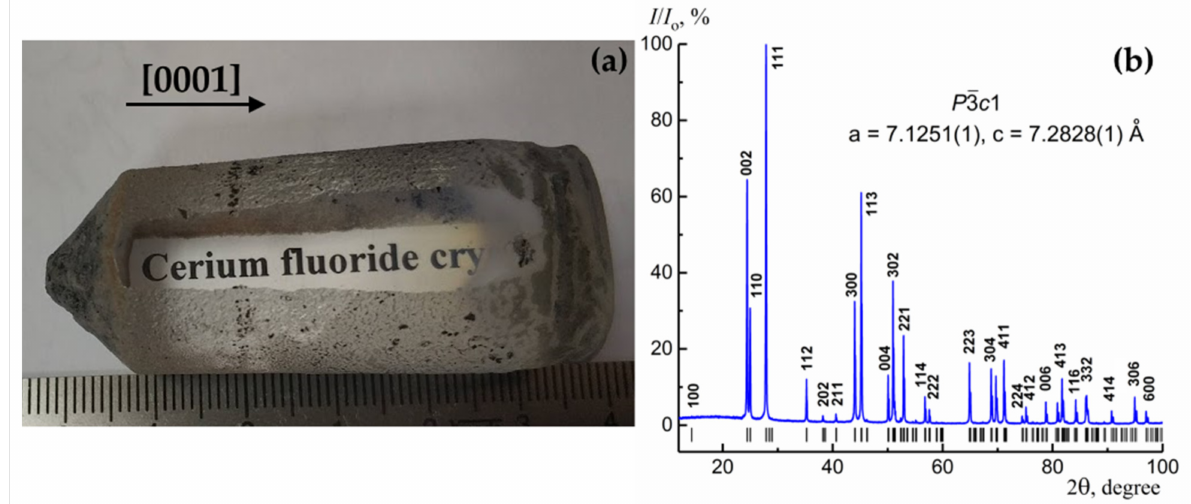
Figure 2. Appearance ( a ) and XRD patterns ( b ) of an as-grown c -oriented CeF 3 single crystal. The positions of the Bragg reflection peaks for the specified fit parameters are indicated.